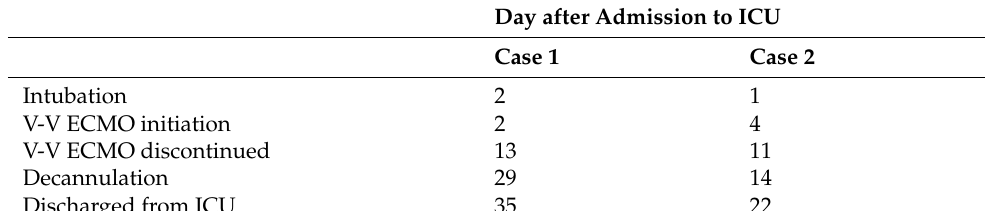
Table 1. The main points of the clinical course of the described cases.